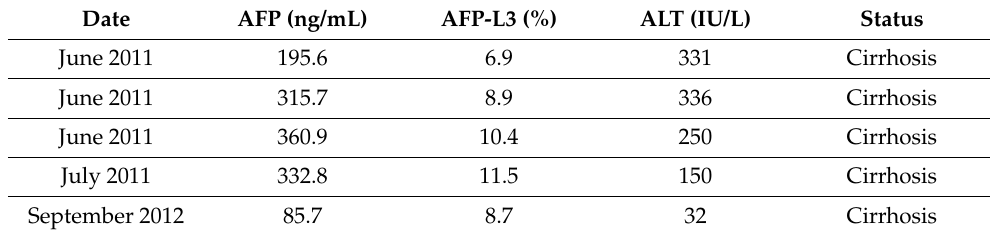
Table 2. Case 2. AFP, L3%, and ALT at the time of cirrhosis diagnosis and after initiation of treatment.